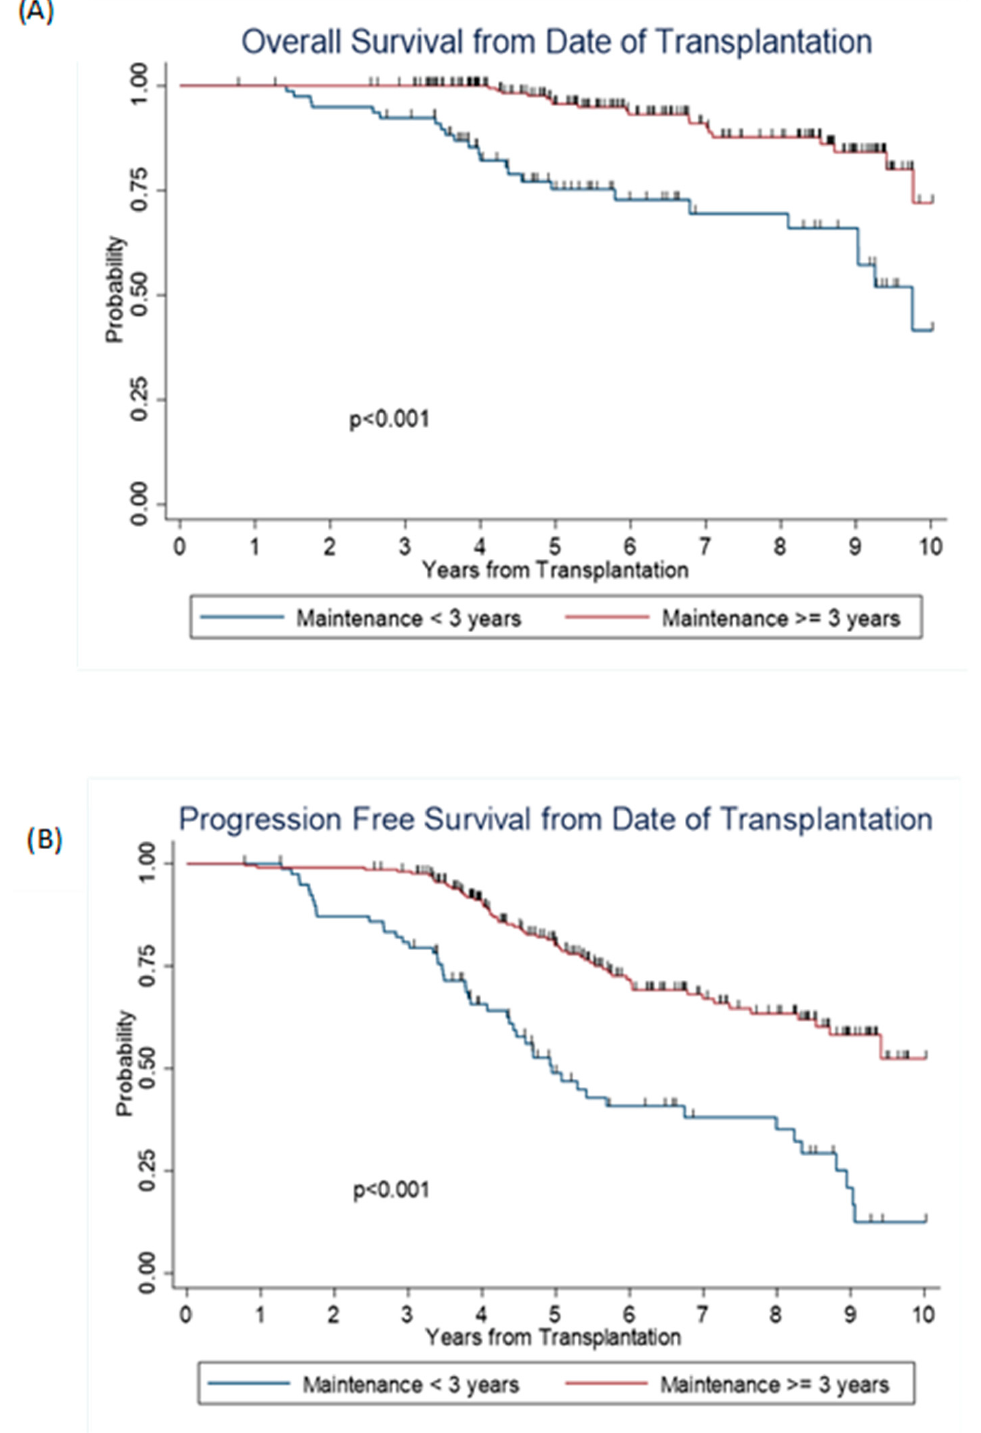
Figure 2. Survival outcomes among patients with CR/VGPR before starting maintenance therapy.